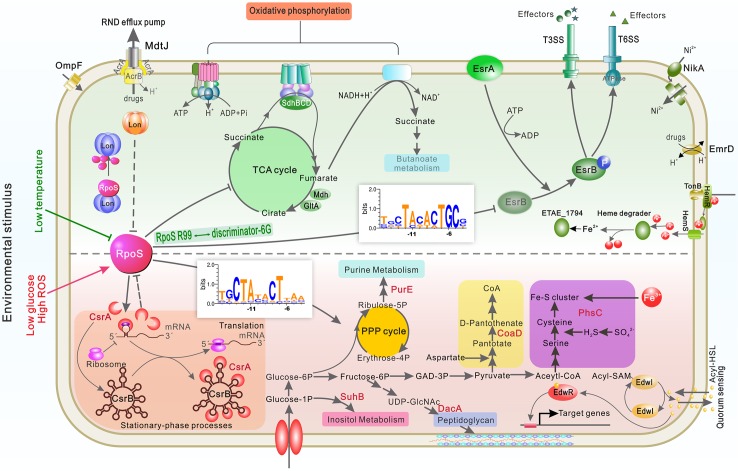
Working model of RpoS control of metabolic and virulence related processes in E. piscicida.Various stresses including low temperature, high ROS, and starvation modulate the level of RpoS. RpoS bound to core RNAP binds to the -10 and -35 elements in promoters enabling (lower) or blocking (upper) transcription. RpoS interactions with different discriminator sequences promote or impede transcription. Arrowed and bar-ended lines indicate activation and repression, respectively.